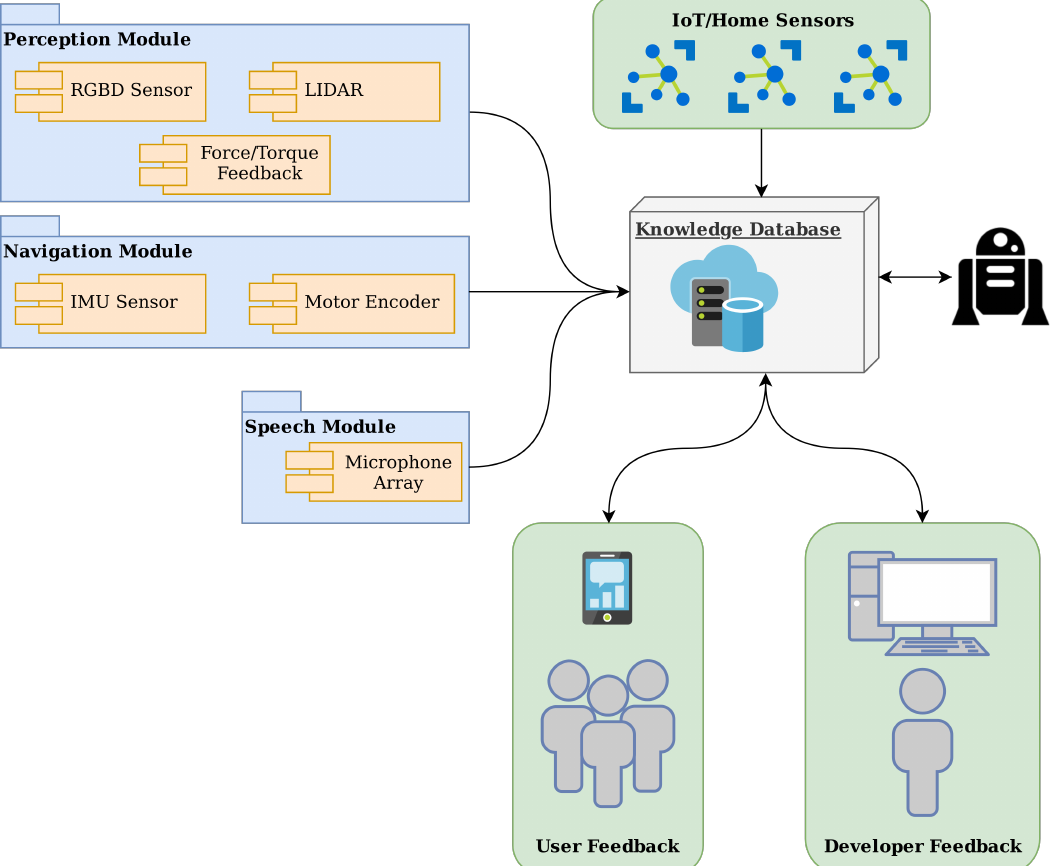
Figure 5. Proposed robot system architecture for domestic